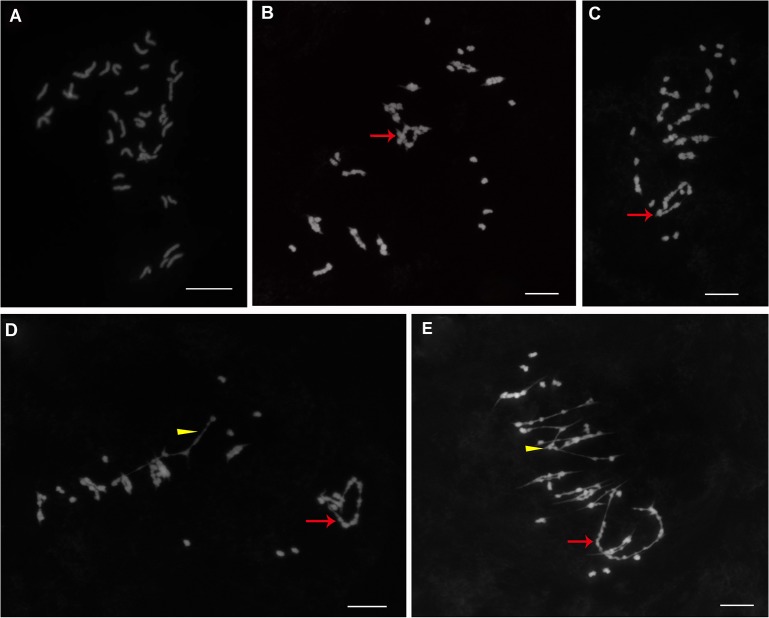
The putative interspecific F1 hybrid was confirmed by cytogenetic observation on mitotic cell and chromosome configuration at metaphase I of meiosis in pollen mother cells (2n = 3x = 39).A: Mitotic cell of interspecific F1 hybrid. B and C: 13I+10II+1VI. D and E: 13I+8II+1IV+1VI. Yellow arrowheads indicate quadrivalents and red arrows indicate hexavalents. Scale bars, 10 μm.